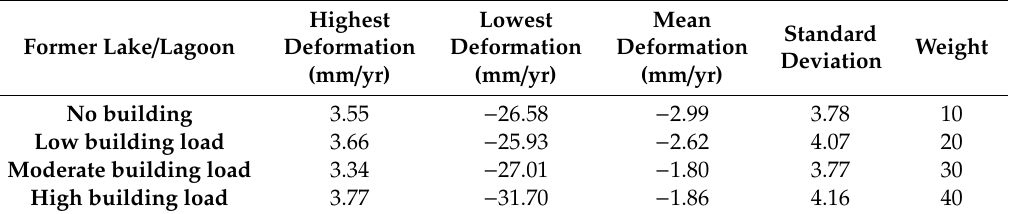
Table 4. Deformation in FLLD areas of